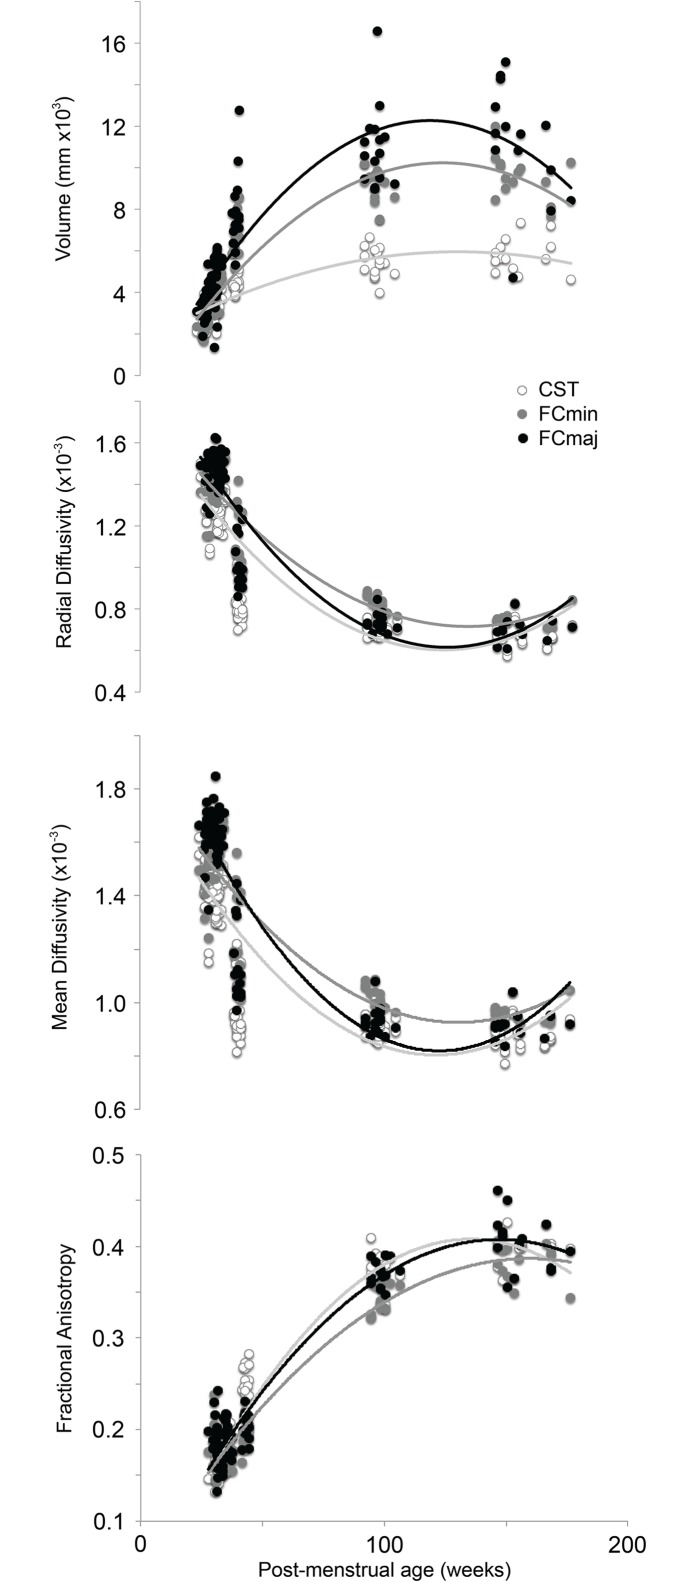
Group-wise developmental changes in fractional anisotropy (FA), axial (L1) and mean diffusivity (MD) and the length of the two remaining eigenvectors (L2 and L3) taking place between viable birth (25 weeks gestational age; wks GA) to 2 years corrected age (CA).CST: corticospinal tracts; FCMIN: forceps minor; FCMAJ: forceps major. X-axis is non-linear and chosen to display the variation across the atlas timepoints.